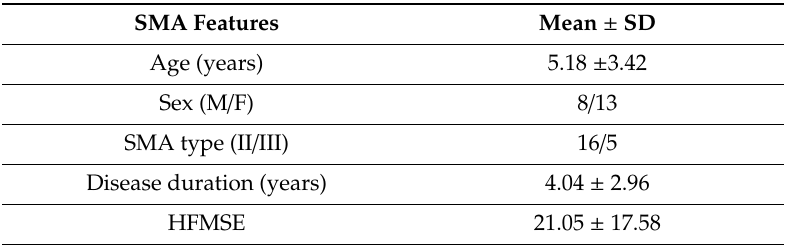
Table 1. Clinical characteristics of the SMA patients at